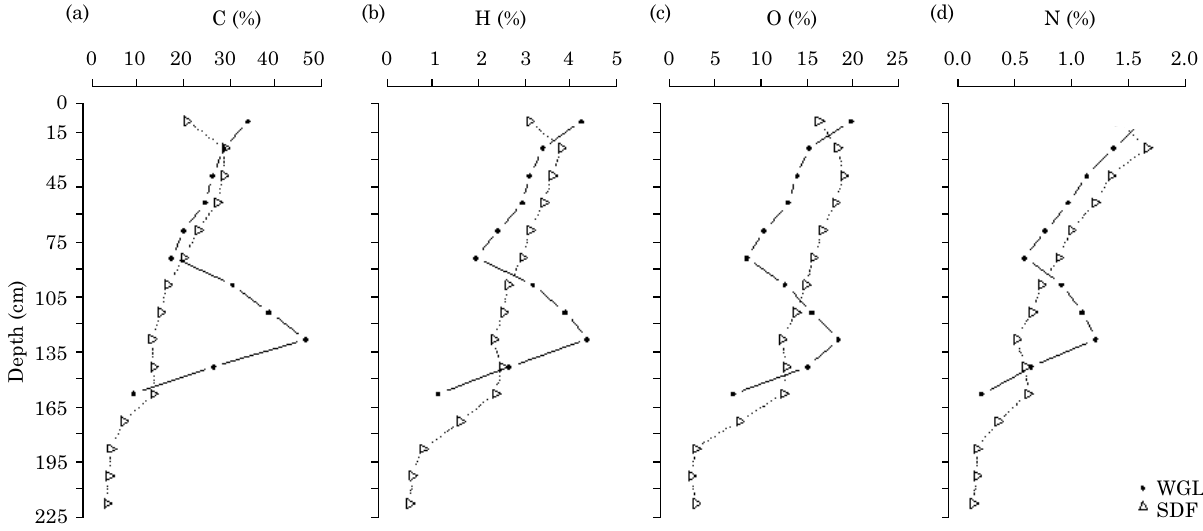
Figure 3. Average contents of (a) carbon (%C), (b) hydrogen (%H), (c) oxygen (%O), and (d) nitrogen (%N) in depth in core samples under wet grassland (WGL) and semi-deciduous forest (SDF) from the peat in the headwaters of the Córrego Cachoeira dos Borges.